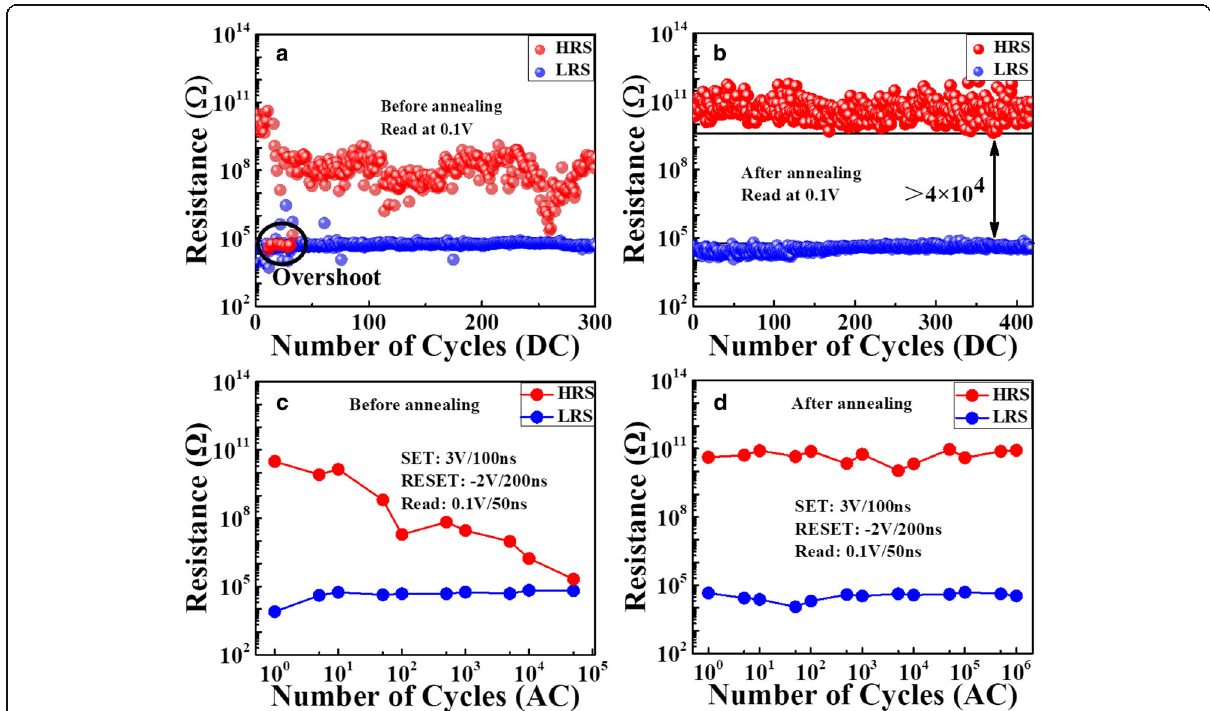
Fig. 4 The cycling results of a the devices without annealing under 300 DC cycles and b the devices with annealing under 400 DC cycles. c, d Endurance characteristics under AC mode with the optimized operation configuration: set 3 V/100 ns; RESET − 2 V/200 ns. Up to 10 6 cycles were obtained for the device after annealing